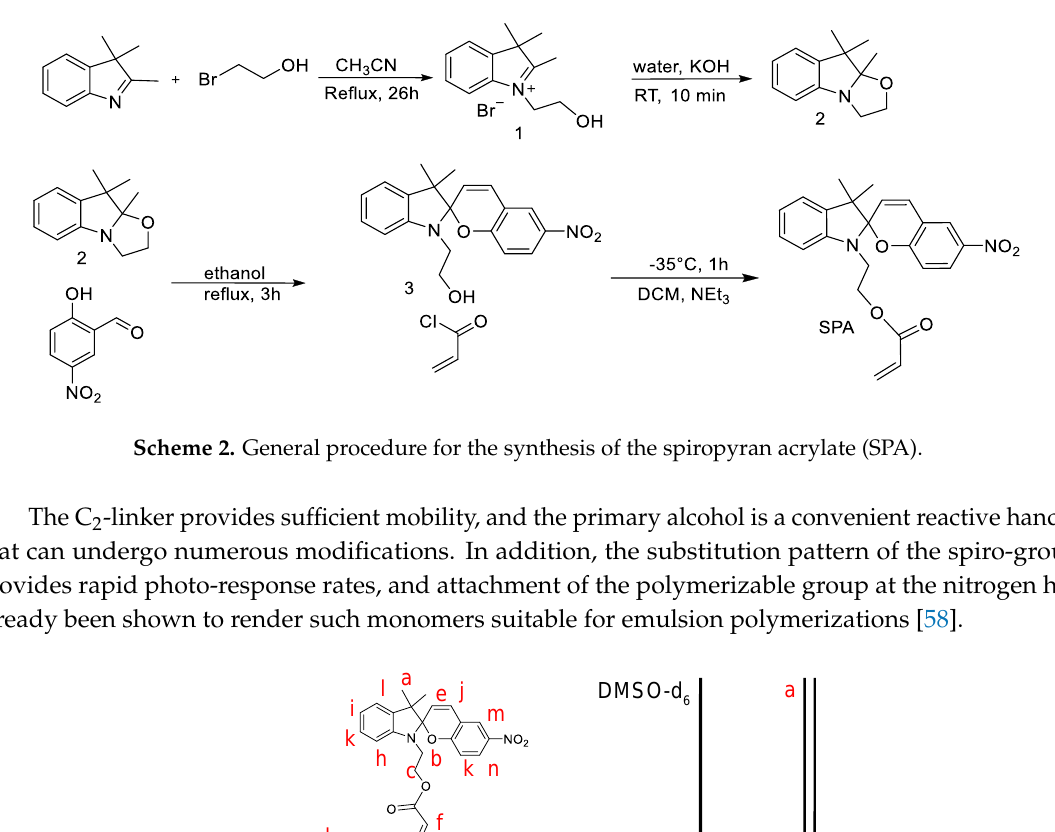
6 . Figure 1. 1 H-NMR spectrum of SPA in DMSO-d 6